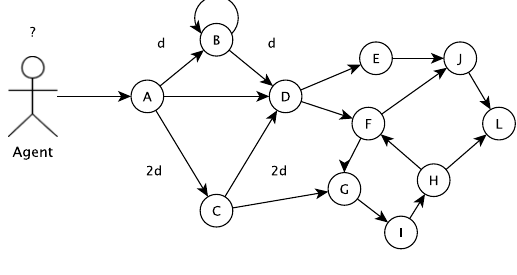
Figure 5. Example of the